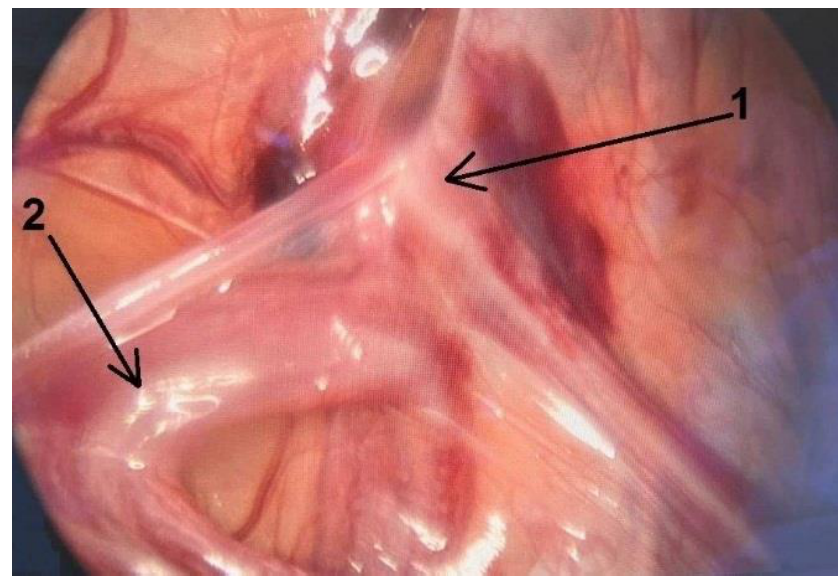
Figure 5. Deferent duct ( 1 ) entered the inguinal canal. The testis with epididymis ( 2 ) was connected to testicular vessels but was disconnected from the deferent duct. Exploration of the inguinal canal revealed a blind-ending deferent duct (arrow; Fig- ure 6).